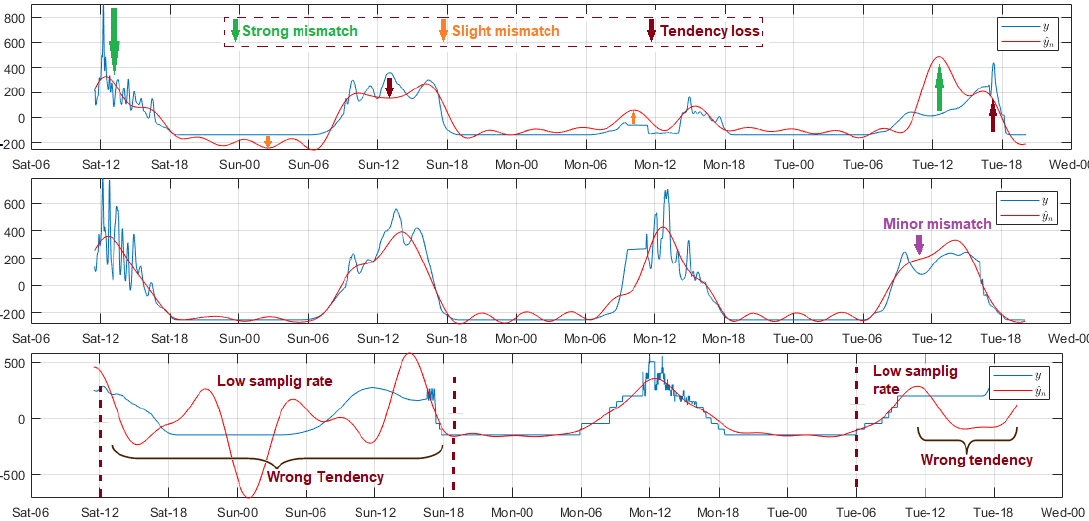
Figure 6. Representative modeled signals of solar radiation. From top to bottom: Node 1 of DigiMesh network with Reg = 1, Node 2 of ZigBee network with Reg = 300, and Node 2 of WiFi network with Reg =